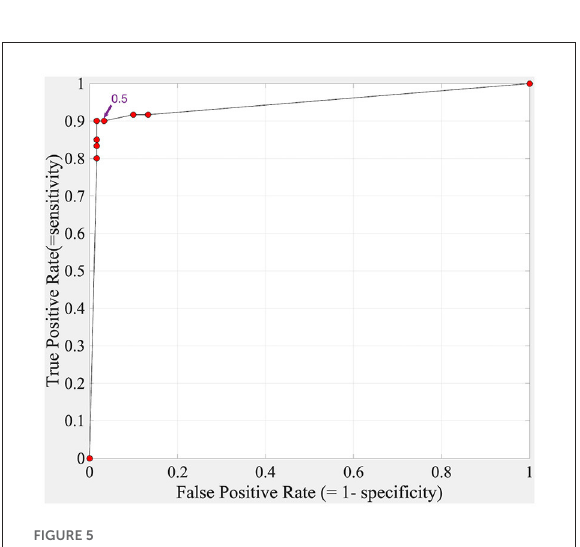
FIGURE5 ROC curve for the Still’s murmur identification algorithm tested on the test